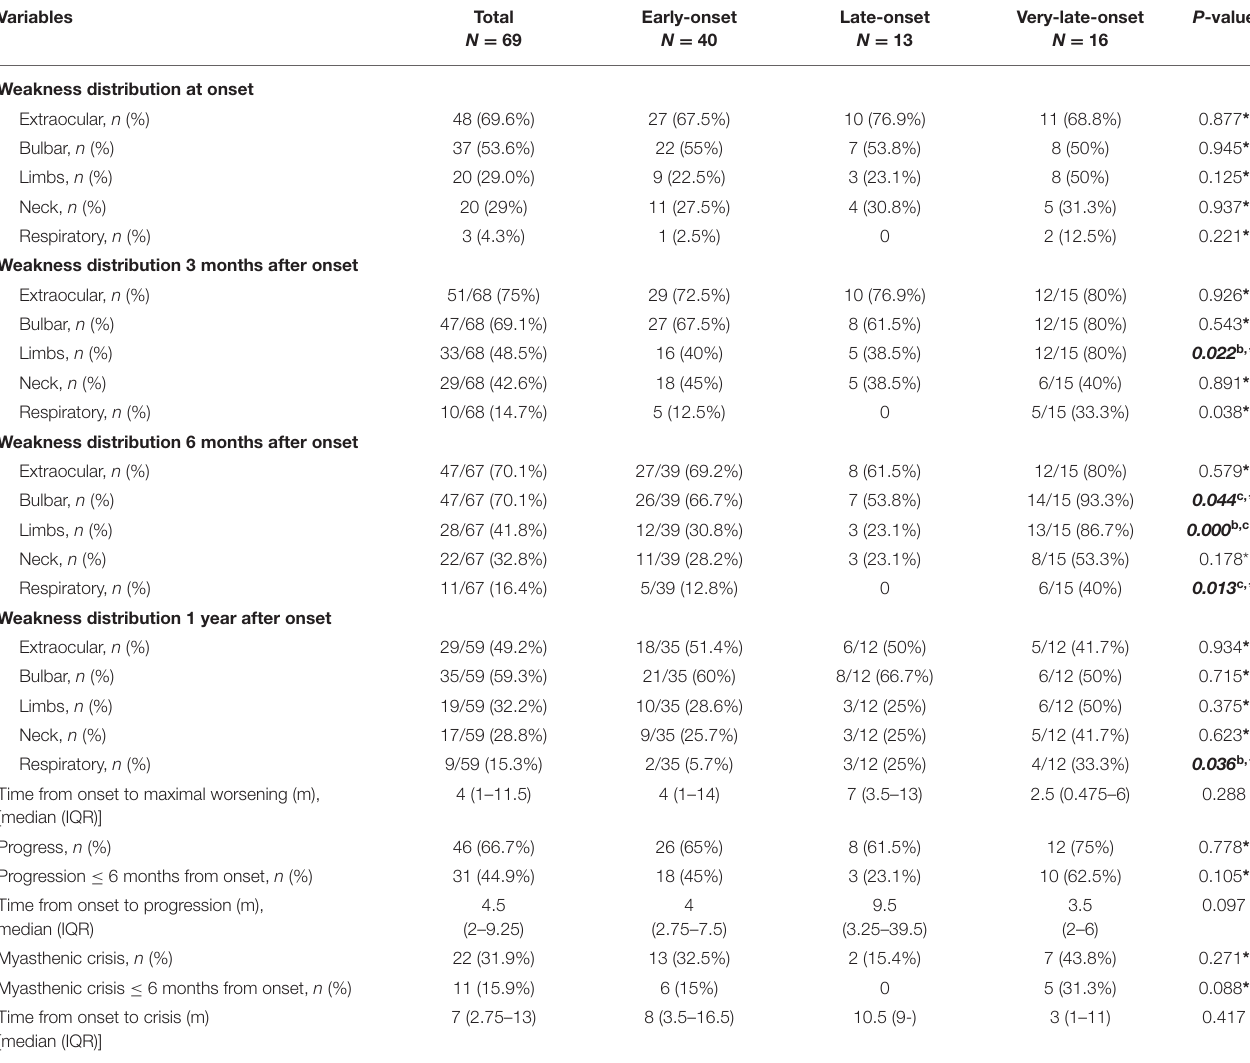
TABLE 2 | Weakness distribution and disease progression in early-onset, late-onset, and very-late-onset MuSK-myasthenia gravis. Variables Total